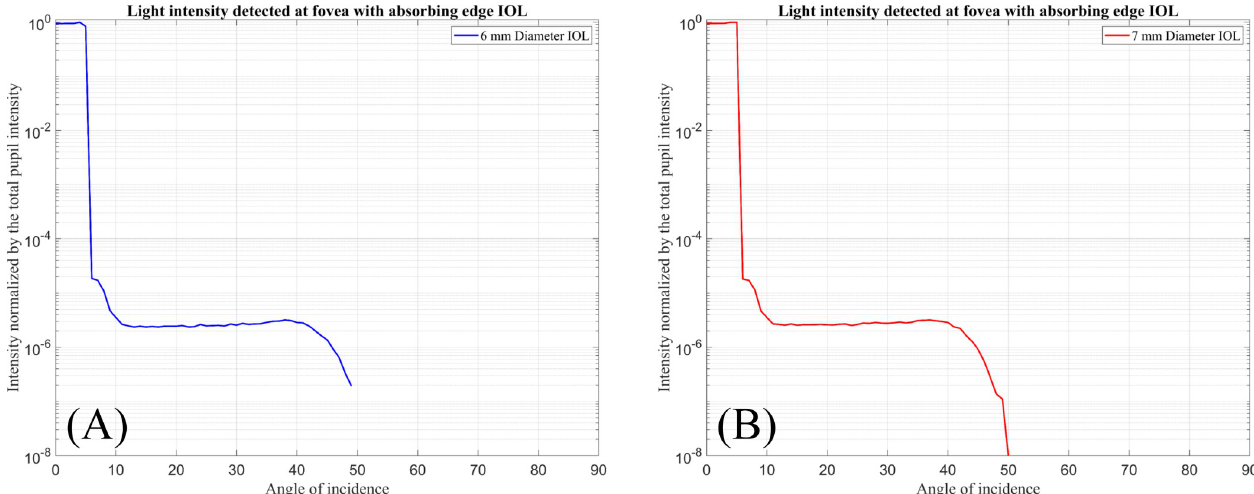
Fig 7. Normalised input intensity detected by Detector-F over the incident ray angle. (A) For 6 mm diameter IOL with absorbing edge surface. (B) For 7 mm diameter IOL with absorbing edge surface.